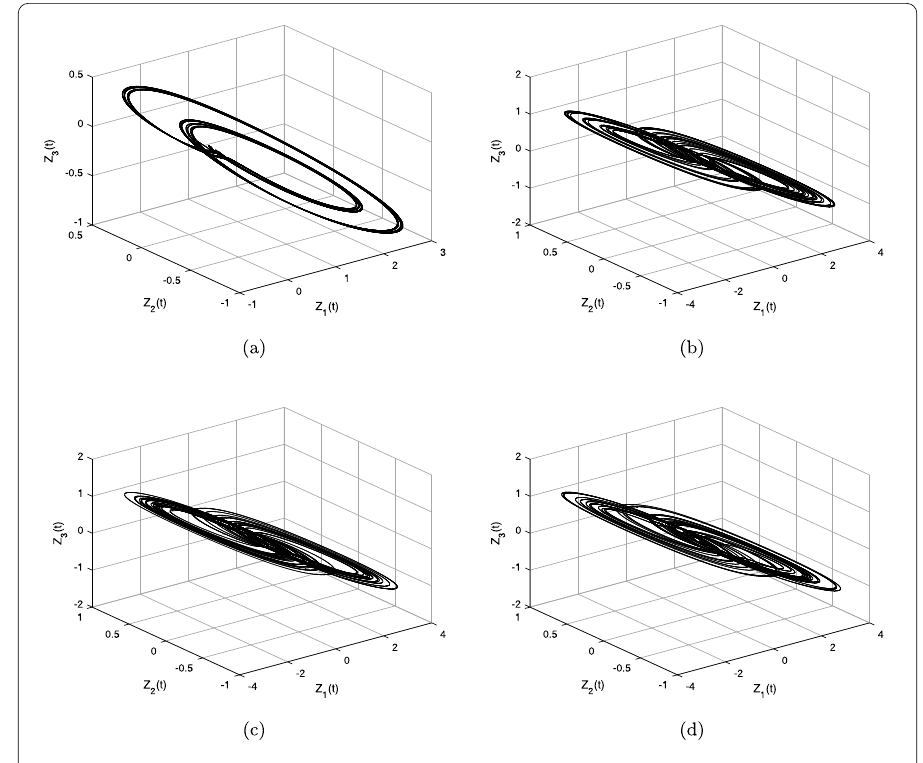
Figure 5 Chaotic attractors for (2) at q = ( a ) 0.95, ( b ) 0.98, ( c ) 0.99, ( d ) 1